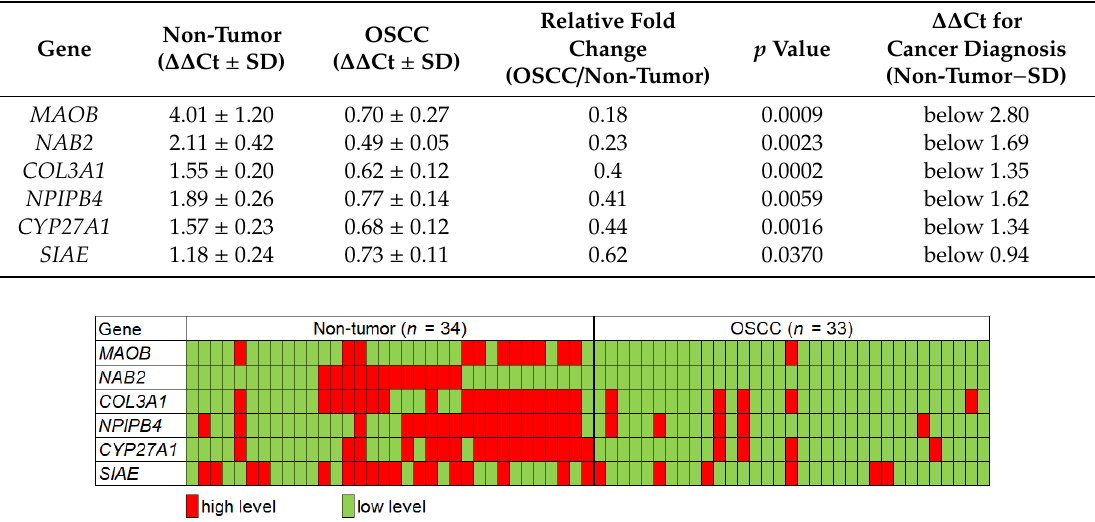
Figure 2. Direct comparison of each mRNA level in the two groups to predict oral squamous cell carcinoma (OSCC). The subjects representing the ΔΔCt below non-tumor group’s average ΔΔCt−SD are marked as “low level” mRNA, which is represented as green color (cancer). The subjects who showed greater ΔΔCt than this value were marked as “high level” expression, which is represented with red color (control). The cut-off of ΔΔCt for cancer diagnosis of each mRNA is 2.80 for MAOB, 1.69 for NAB2, 1.35 for COL3A1, 1.62 for NPIPB4, 1.34 for CYP27A1, and 0.94 for SIAE.